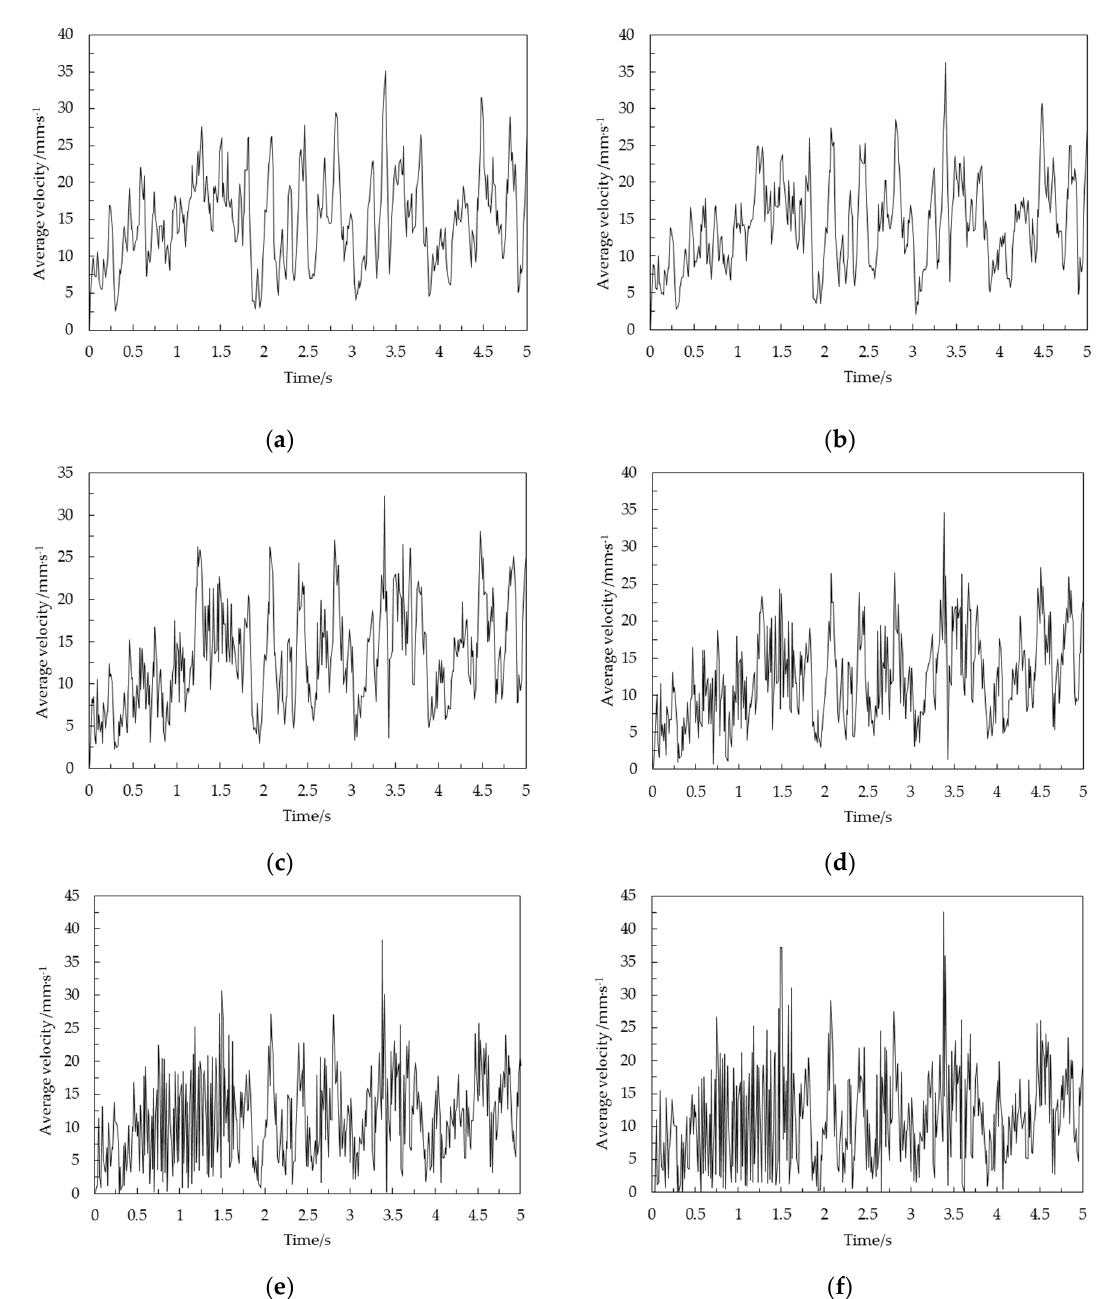
Figure 7. Average velocity over time of the corn grain in different areas: ( a ) average velocity over time of the corn grain in the 0–20 mm area; ( b ) average velocity over time of the corn grain in the 20–40 mm area; ( c ) average velocity over time of the corn grain in the 60–80 mm area; ( d ) average velocity over time of the corn grain in the 100–120 mm area; ( e ) average velocity over time of the corn grain in 160–180 mm area; ( f ) average velocity over time of the corn grain in the area below 20 mm on the upper free surface.